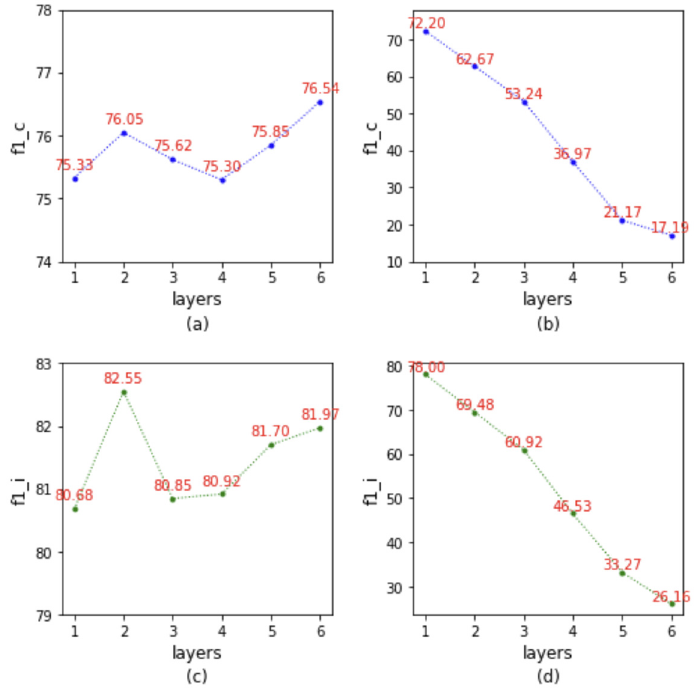
Figure 6. Influence of the model depth on F1 value of trigger classification (blue dotted lines) and identification (green dotted lines). ( a , b ) represents F1 curves of our model and the GCN model on trigger classification, respectively. ( c , d ) are F1 curves on trigger identification.